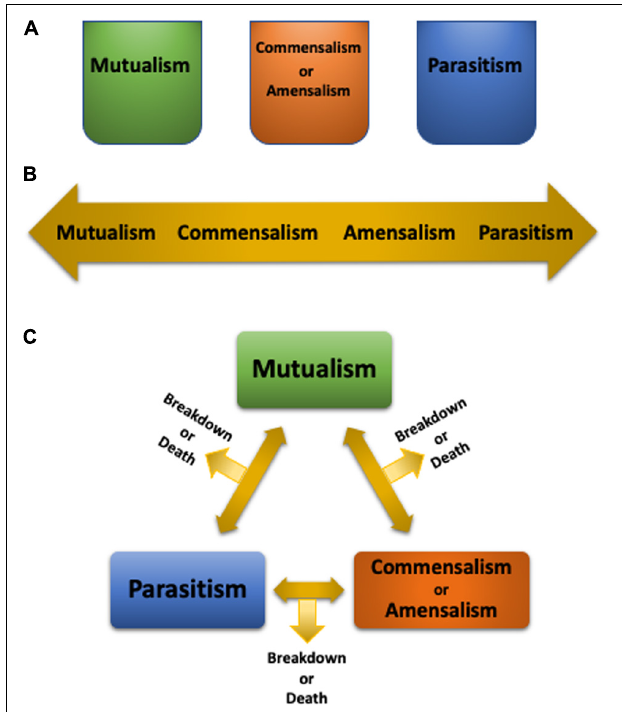
FIGURE 1 | Depiction of symbiosis states as discrete separate entities (A) , a continuum (B) , or as oscillating between one state to another based on context (C)